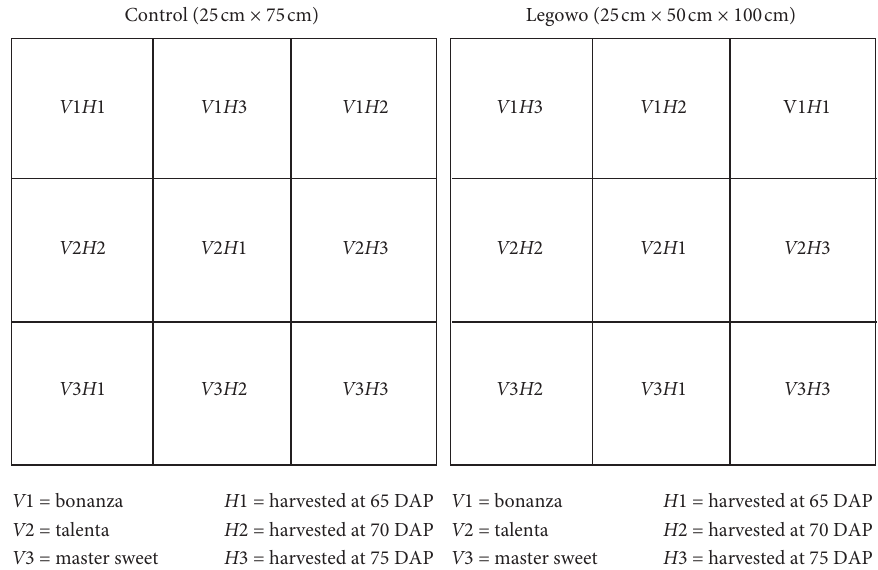
Figure 1: Experimental field treatment by adopting a split-split plot design. Table 2: Summary of F statistic followed by the probability of the effect of the spacing system, variety, and harvest time on growth, yield, and sugar content of sweet